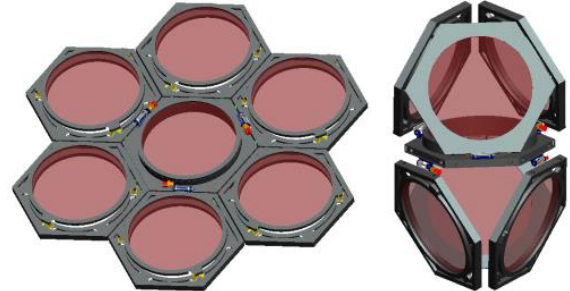
Figure 2. Scheme of “6+1” petal-type